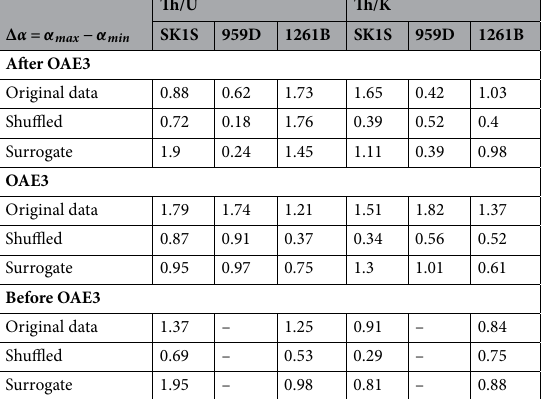
Table 3. The multifractal spectrum widths of the thorium–uranium and thorium–potassium distributions before, within and after the OAE3 intervals at Songliao Basin (SK1S), Deep Ivorian Basin (959D) and Demerara Rise